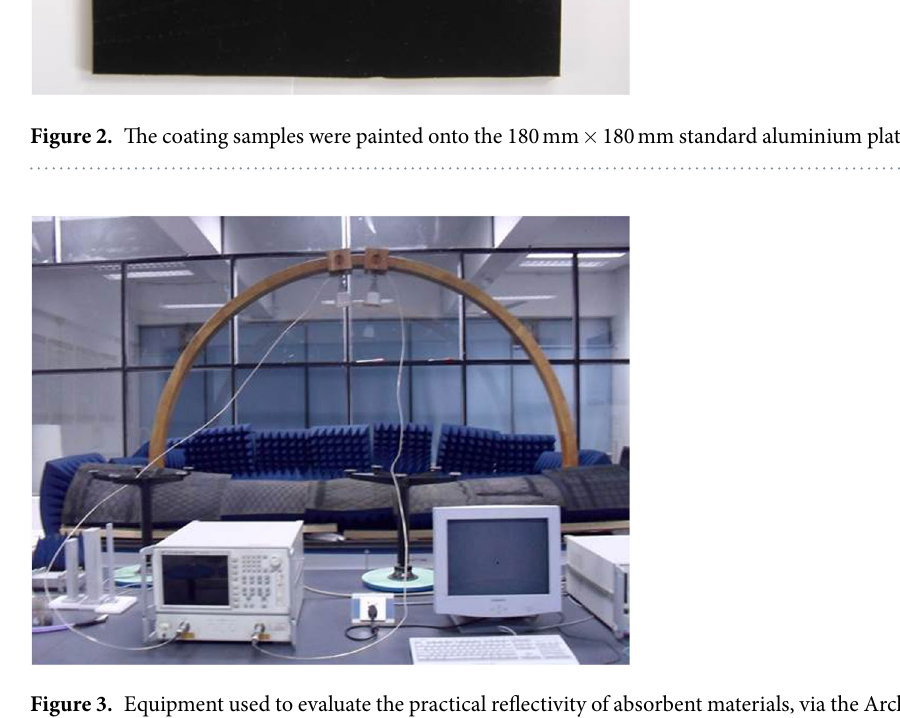
Figure 3. Equipment used to evaluate the practical reflectivity of absorbent materials, via the Arch method.